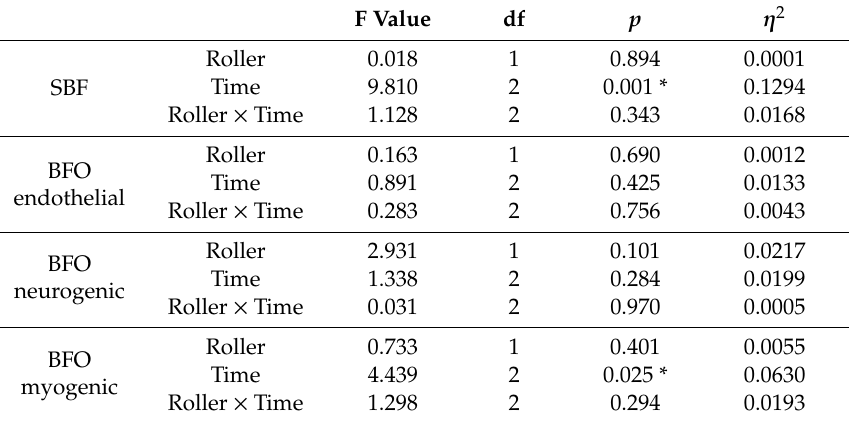
Table 3. Two-way ANOVA analysis of SBF and normalized energy of BFO.